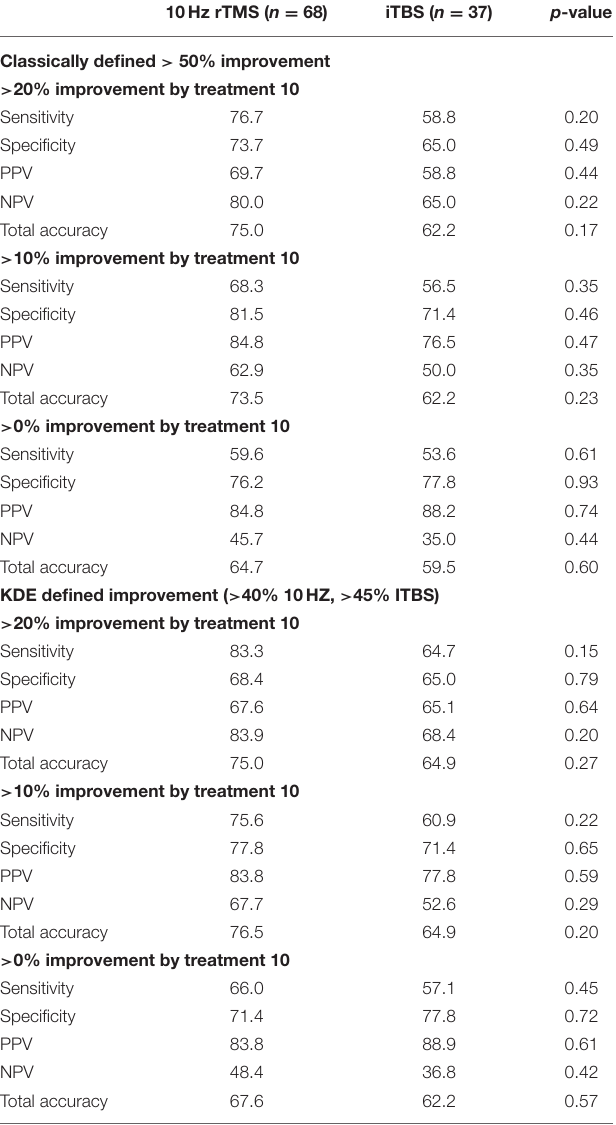
TABLE 2 | Early improvement confusion matrices determining final treatment predictive capacity differences between 10Hz rTMS and